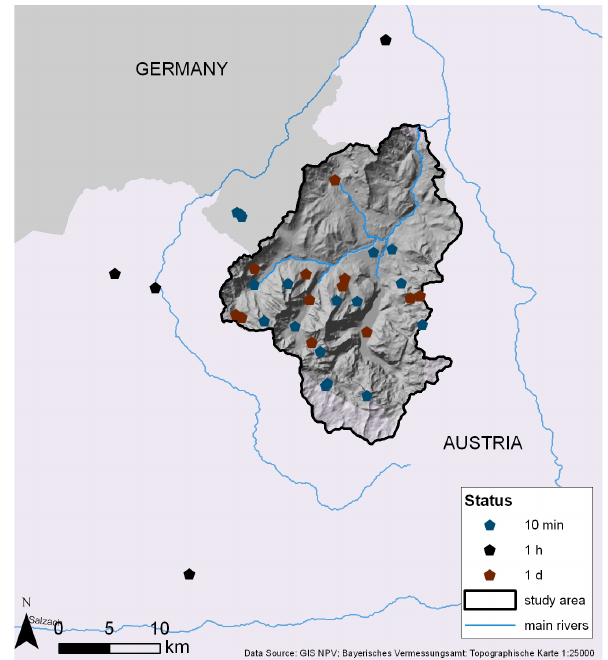
Fig. 4. Locations of weather stations within and outside the study